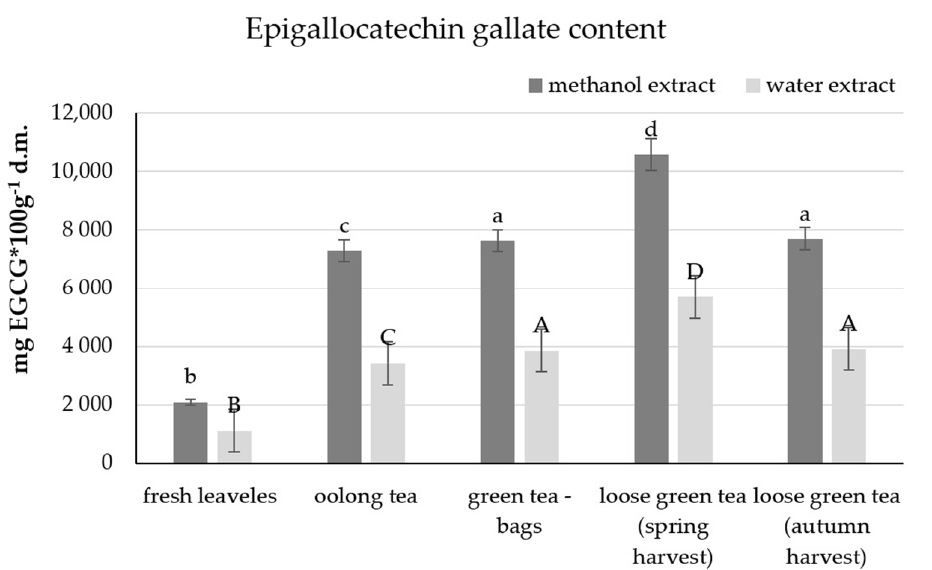
Figure 2. Epigallocatechin gallate content in the leaves of the tea plant and various types of tea. The same letter a, b, c indicates no statistically significant differences between the mathanol extracts, and A, B, C—between the water extracts of the analyzed teas.